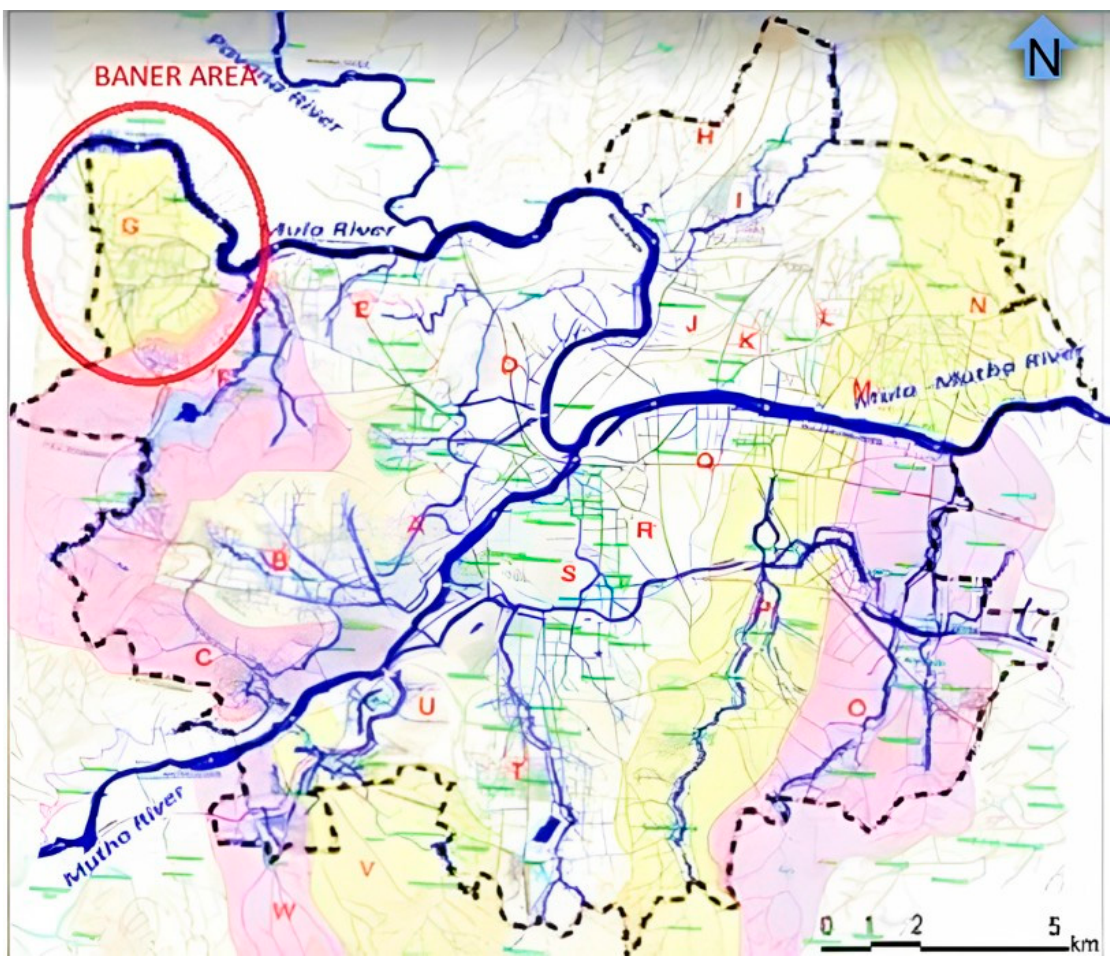
Figure 1. Pune drainage Map-showing study area G Basin